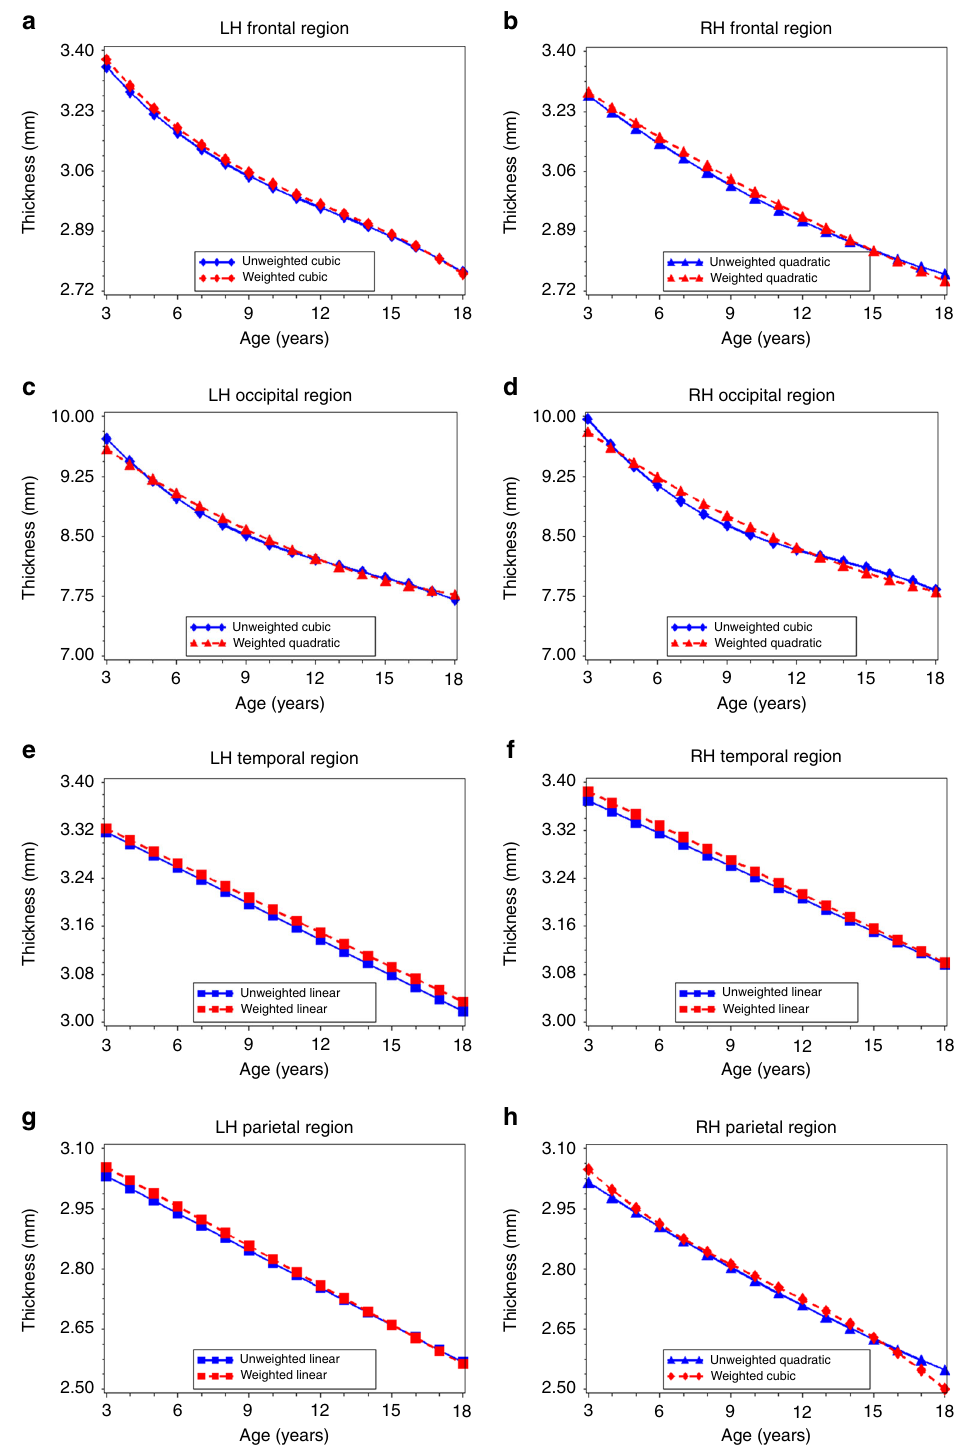
Fig. 3 Age-related variation in cortical thickness for each lobe of the brain. Using the best- fi tting regression models described in Table 2, we calculated the predicted values by age for: left ( a ) and right ( b ) frontal lobe thickness; left ( c ) and right ( d ) occipital lobe thickness; left ( e ) and right ( f ) temporal lobe thickness, and left ( g ) and right ( h ) temporal lobe thickness in the unweighted ( blue lines ) and weighted ( red lines ) samples. LH left hemisphere, RH right